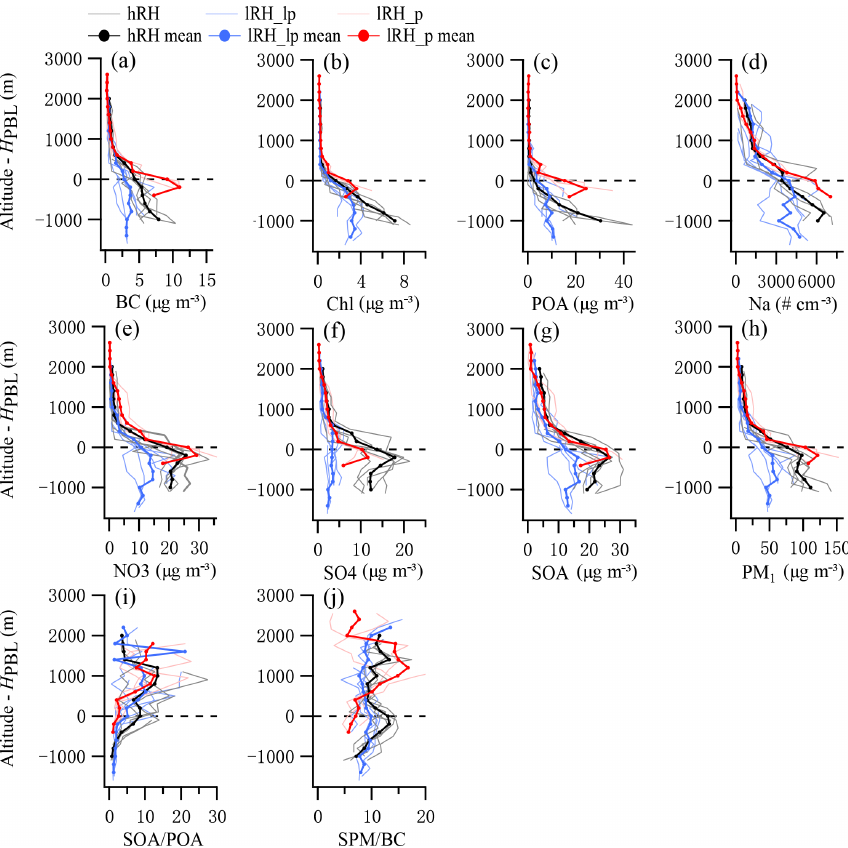
Figure 3. Vertical profiles of aerosol properties under low RH and less polluted condition (lRH_lp), low RH and polluted condition (lRH_p), and high RH condition (hRH). (a–d) Primary aerosol components and number concentrations, “ N a ” denotes the number concentration at 0.12–3µm measured by the PCASP, (e–h) secondary aerosol components and mass concentrations, (i) ratio of SOA over POA, (j) ratio of SPM (secondary particulate matter) over BC. The solid lines show mean values in 100m altitude